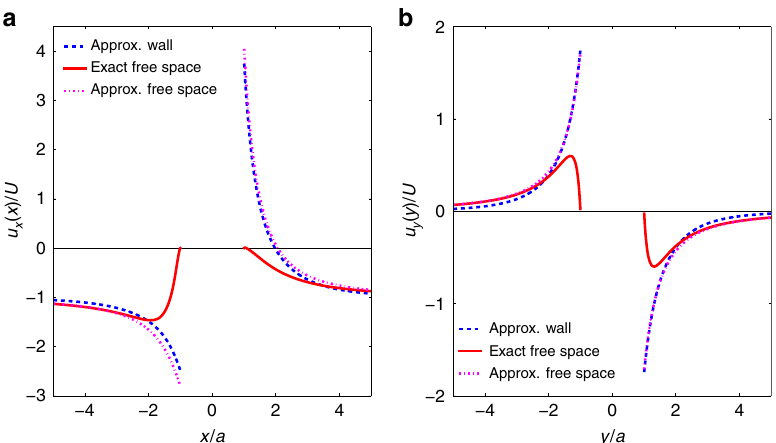
Fig. 5 In fl uence of the solid wall on the velocity fi eld. Components of the fl ow fi eld [( a ): u x ( x , y = 0); ( b ) u y ( x = 0, y )] in the equatorial plane of the Janus sphere, calculated using the expression obtained by the singularities expansion in free space (see Supplementary Note 2), the singularities expansion and their images that account for the presence of a no-slip wall (Eq. (6)) and the exact solution in free space, for the boundary condition at the surface of the colloid v ( θ ) given in Eq.